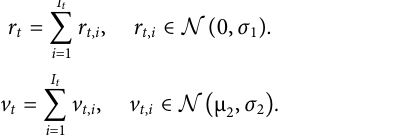
Frontiers in Physics |